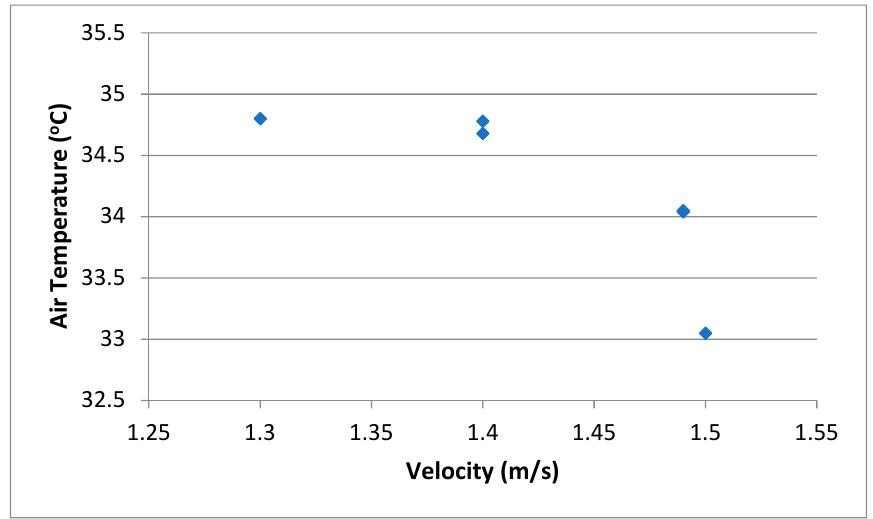
Figure 13. Relationship between mean air temperature and wind velocity at pedestrian level.